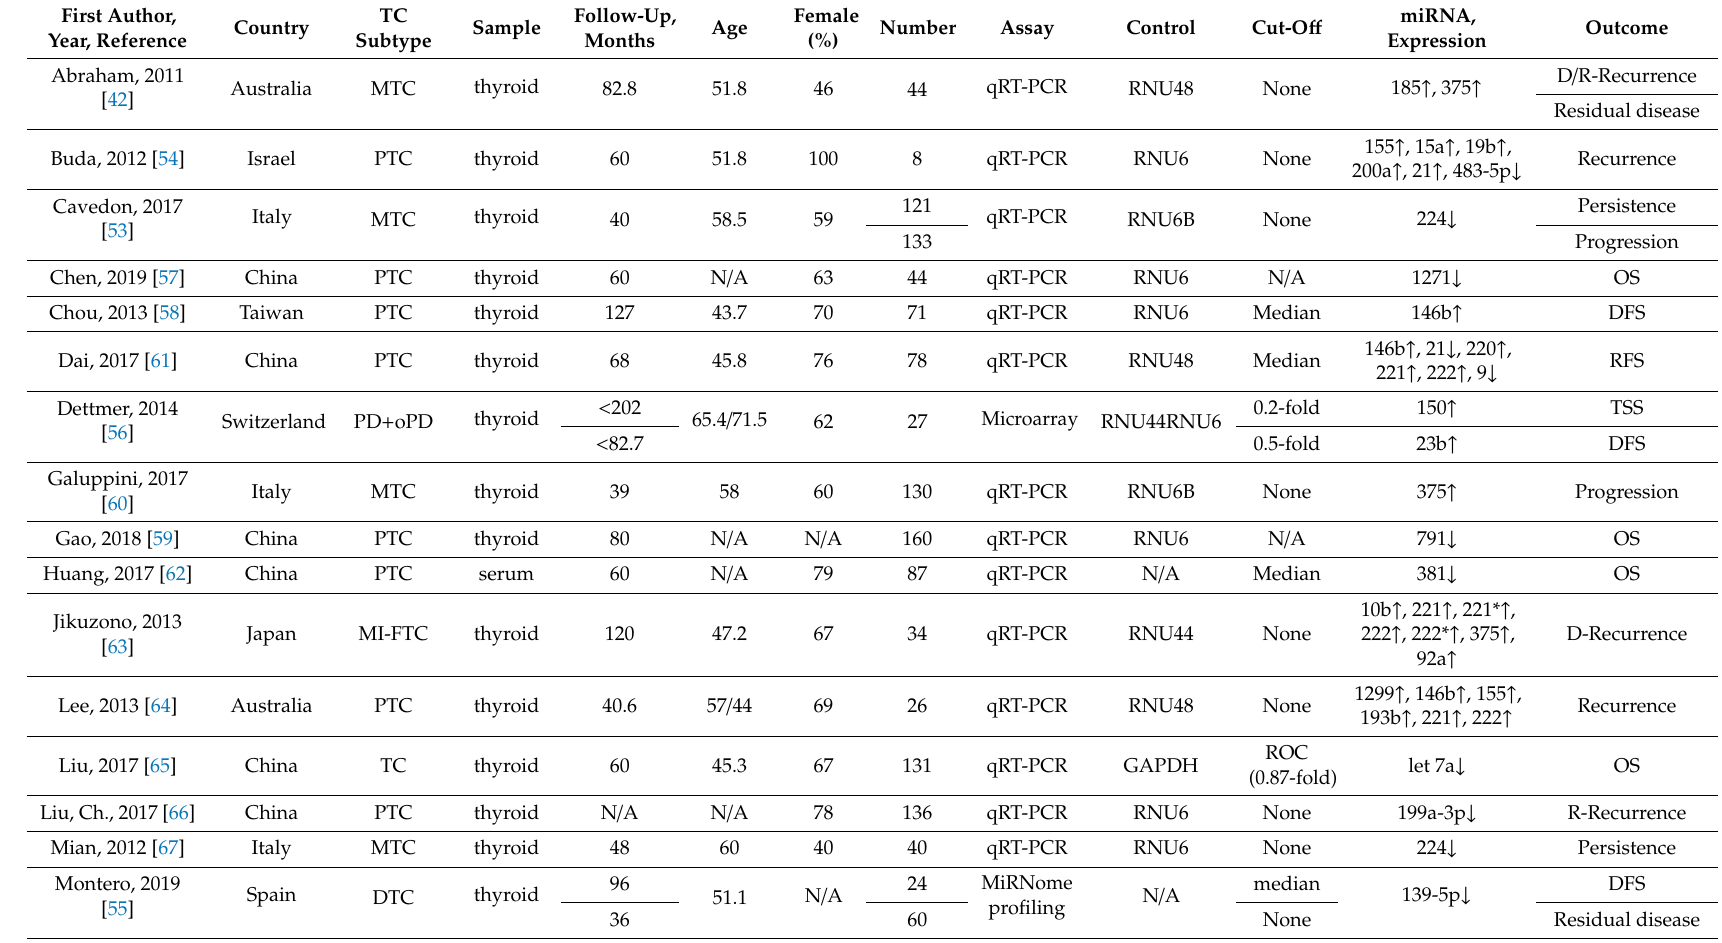
Table 1. Characteristics of the included